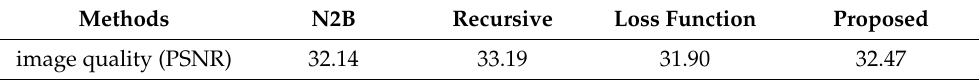
Figure 8. Example images of raindrops removal: ( a ) a clean image; ( b ) a raindrop noisy image; ( c – f ) example images of raindrops removal using various noise removal methods. Table 8. Performance comparison for removing